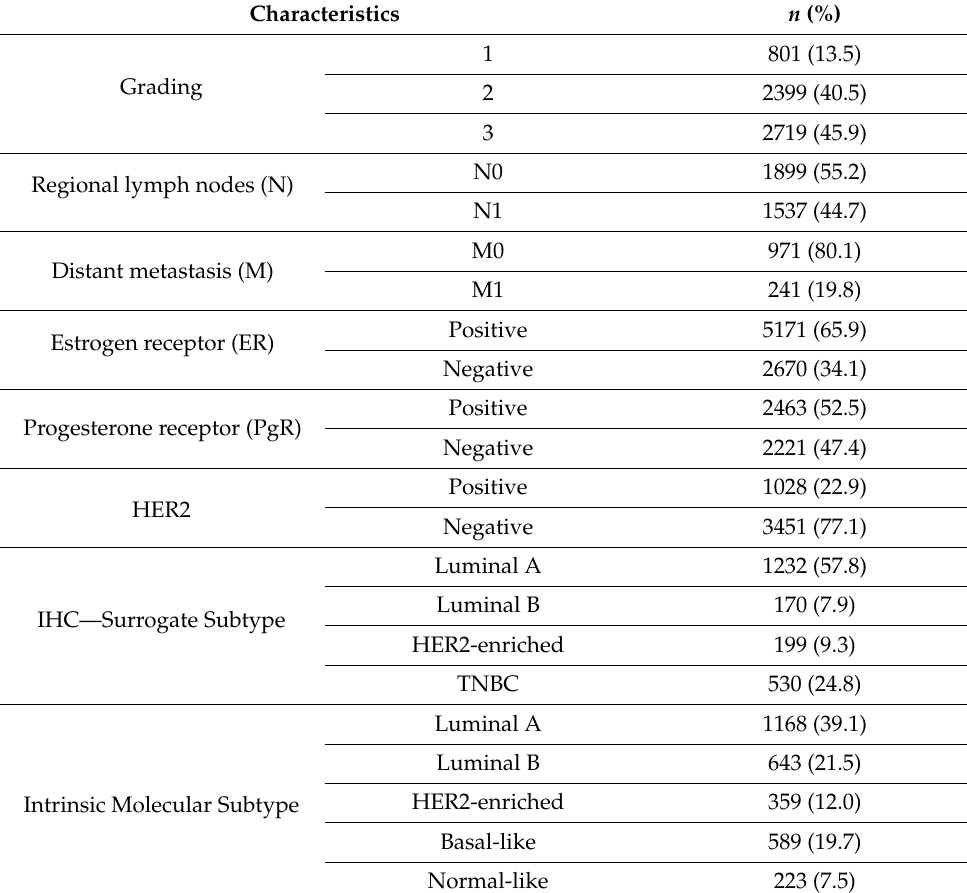
Table 1. Clinical characteristics of BC